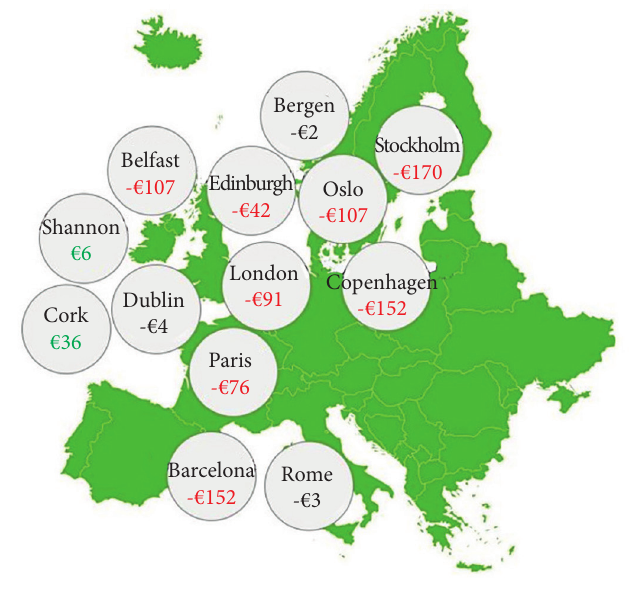
Figure 3. Norwegian average profit per seat by origin airport 2017. Source: Aviation Analytics